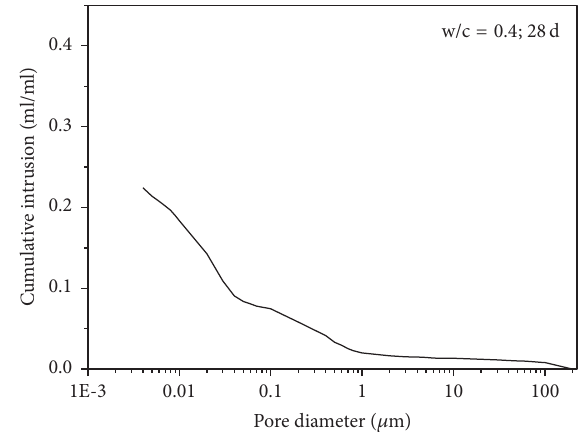
Figure 3: Parametric analysis: log-log diagram of solid fraction against pore